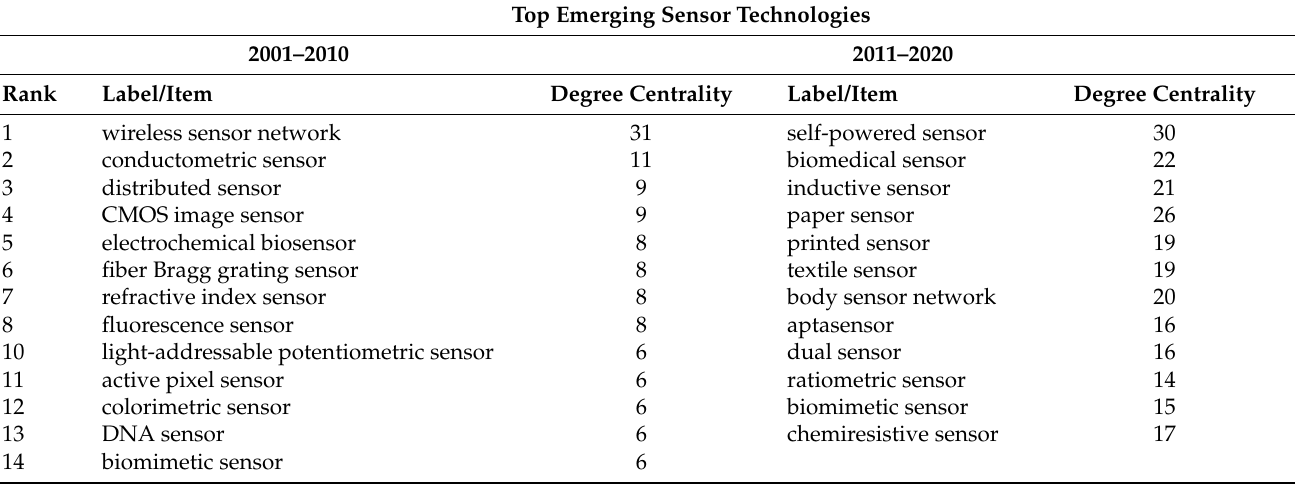
Table 4. Top emerging items associated with sensor technologies in networks from 2001 to